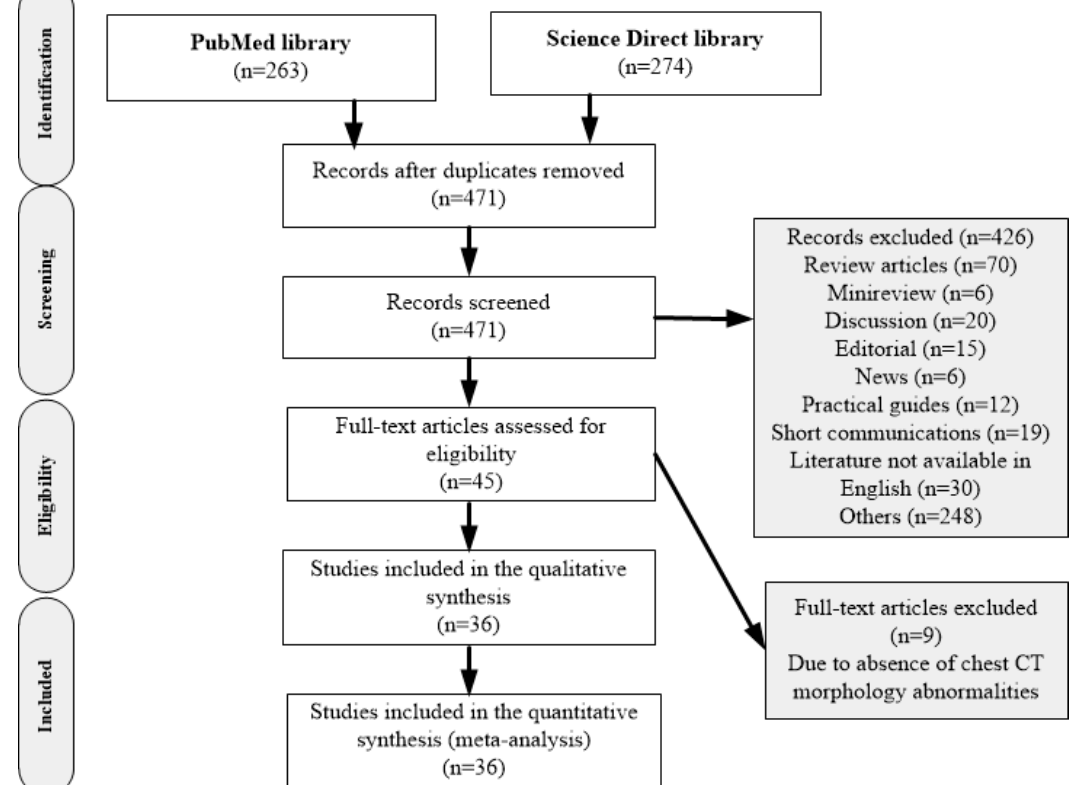
Figure 1. Study of inclusion and exclusion flowcharts adapted from the Preferred Reporting Items for Systematic Reviews and Meta-Analyses (PRISMA). n = number of literature and PRISMA = Preferred Reporting Items for Systematic Reviews and Meta-analyses,CT = Computed tomography.